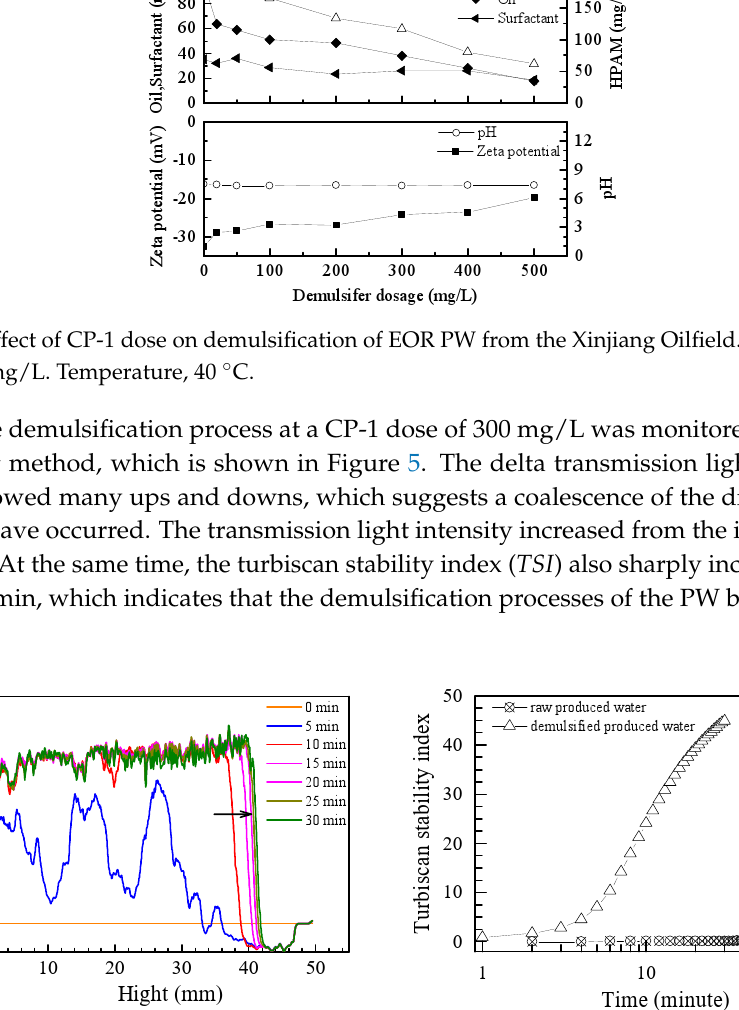
Figure 5. Variations of delta transmission light intensity and TSI with time. Oil content in PW, 358.5 mg/L. Dose of demulsifiers, 300 mg/L. Temperature, 40 °C.